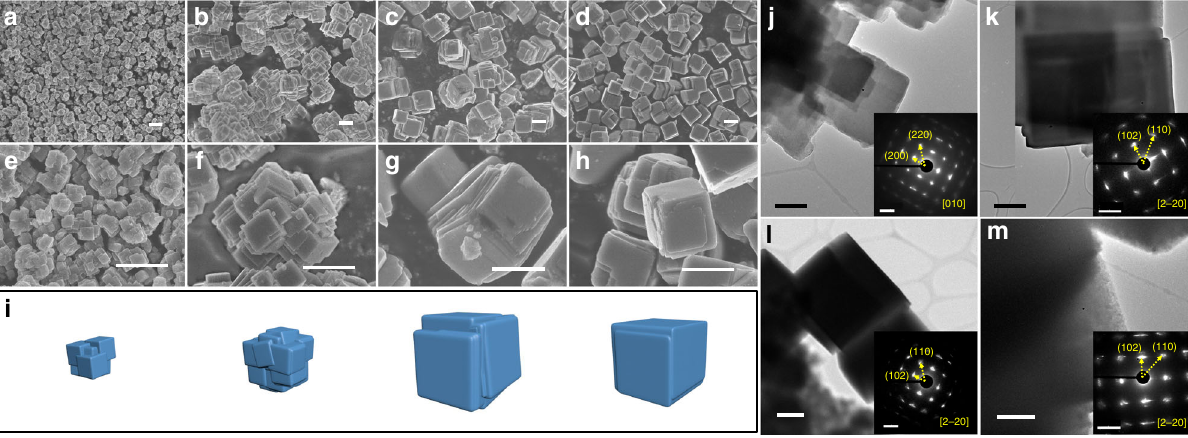
Fig. 2 SEM, TEM with SAED of different samples. SEM images of ( a – d ) PB-S1, PB-S2, PB-S3, and PB-S4 samples respectively and ( e – h ) corresponding enlarged images, ( i ) illustration of evolution process of highly crystalline Na 2 − x FeFe(CN) 6 , ( j – m ) STEM images with inset SAED of PB-S1, PB-S2, PB-S3, and PB-S4 samples respectively. Scale bars: 1 μ m ( a – h ); 200 nm ( j , k ); 500 nm ( l , m ); 2 1/nm for inset SAED patterns ( j – m